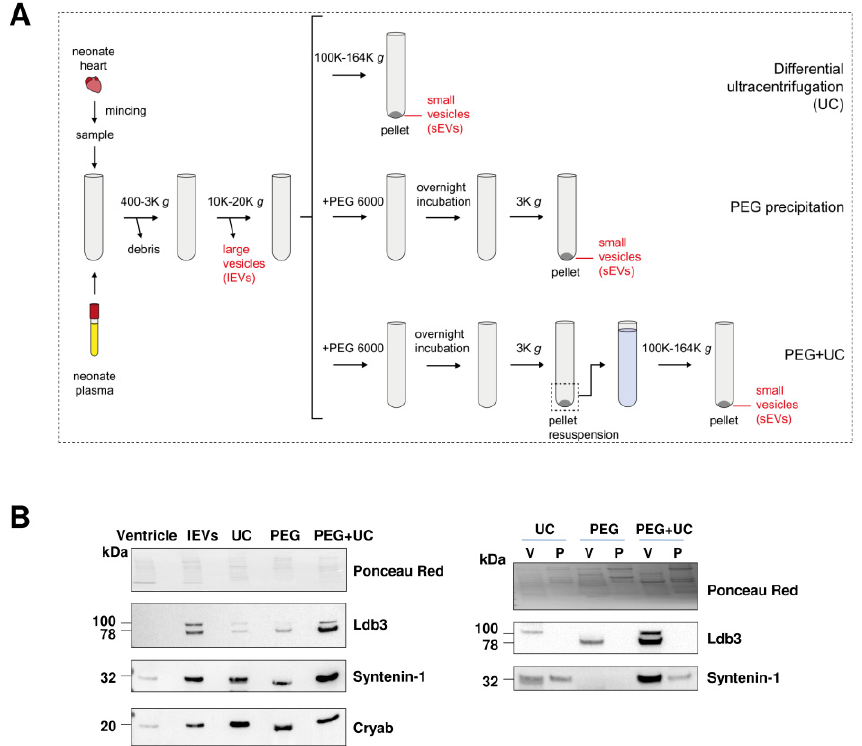
Figure 3. Ldb3 is enriched in cardiac EVs compared to heart tissue and plasma EVs. ( A ) Scheme of the three EV isolation techniques from neonate rat heart: ultracentrifugation (UC), polyethylene glycol precipitation without (PEG) or with UC (PEG + UC). K: × 1000. ( B ) Detection of Ldb3, syntenin–1, and Cryab by Western blot of EV populations obtained using the three isolation techniques. Equal amount of proteins were loaded for each blot as shown by Ponceau Red staining. V: ventricle; P: plasma.